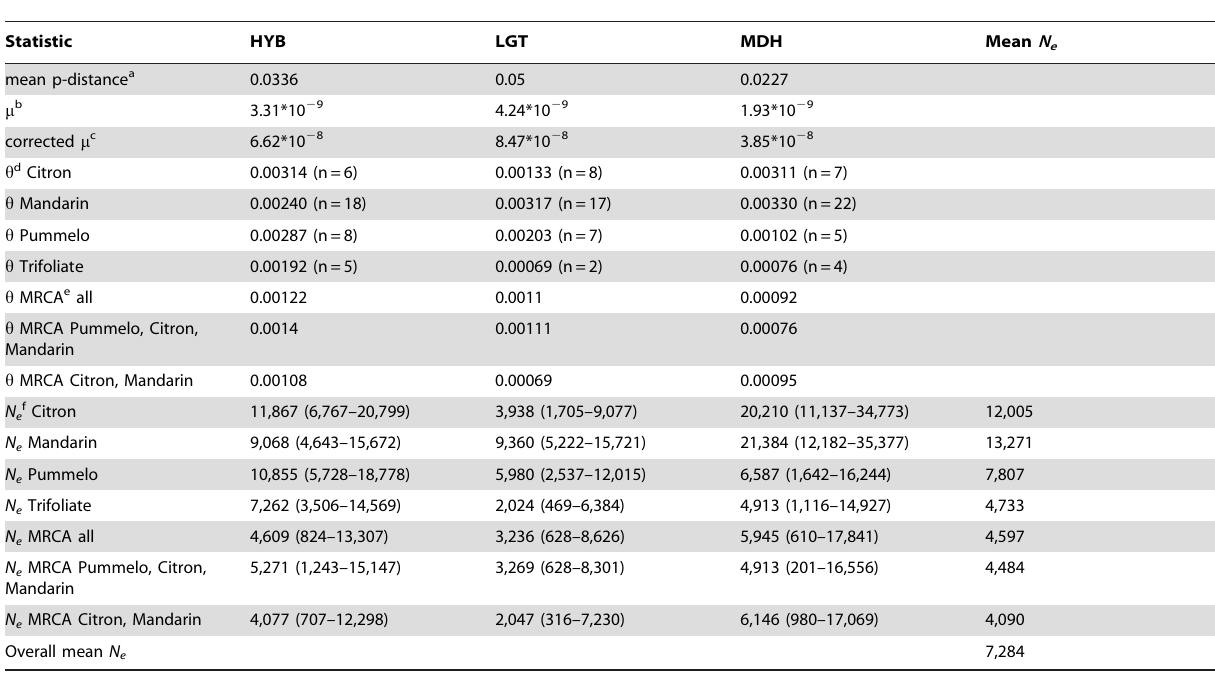
Table 3 . Data used in the estimation of effective population size ( N e